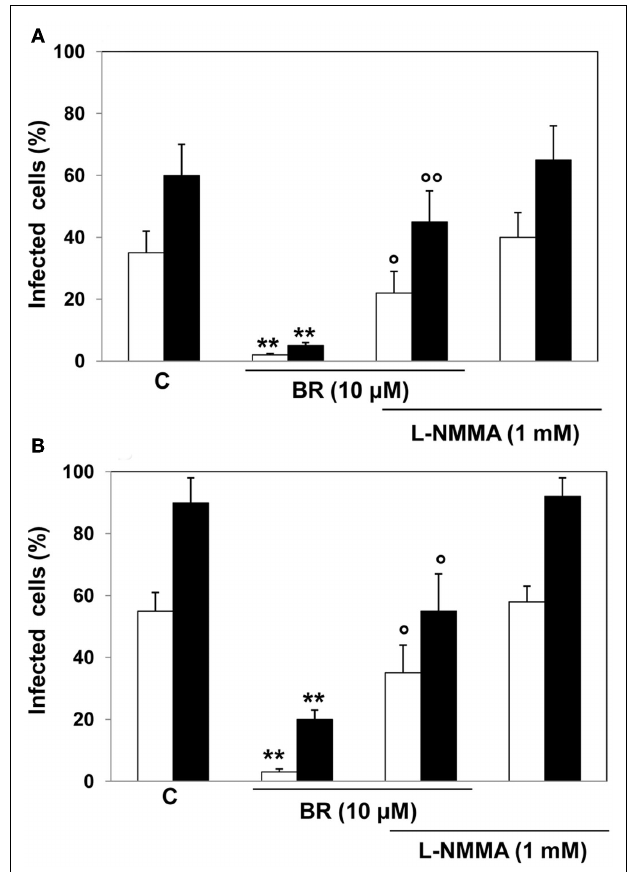
FIGURE 6 | Effect of bilirubin (BR) plus the nitric oxide synthase inhibitor L-NG-monomethyl arginine citrate (L-NMMA) on herpes simplex virus type 1 (HSV-1) and enterovirus EV71 replication. Hep-2 (A) andVero (B) cells were pre-incubated with 1mM L-NMMA for 1h and then with L-NMMA plus 10 μ M BR for further 2h. At the end of incubation, the medium containing L-NMMA plus BR was removed and Hep-2 andVero cells infected with HSV-1 and EV71 (1 × 10 5 PFU), respectively. After 2h, the inocula were removed and the cells incubated in culture medium for 24 (white columns) or 48h (black columns). Data are expressed as the percentage of infected cells, mean ± SEM of six individual samples per group. ** P < 0.01 versus respective controls (C) and ˚ P < 0.05 and ˚˚ P < 0.01 versus 10 μ M BR after 24h (white columns) and 48h (black columns) from viral